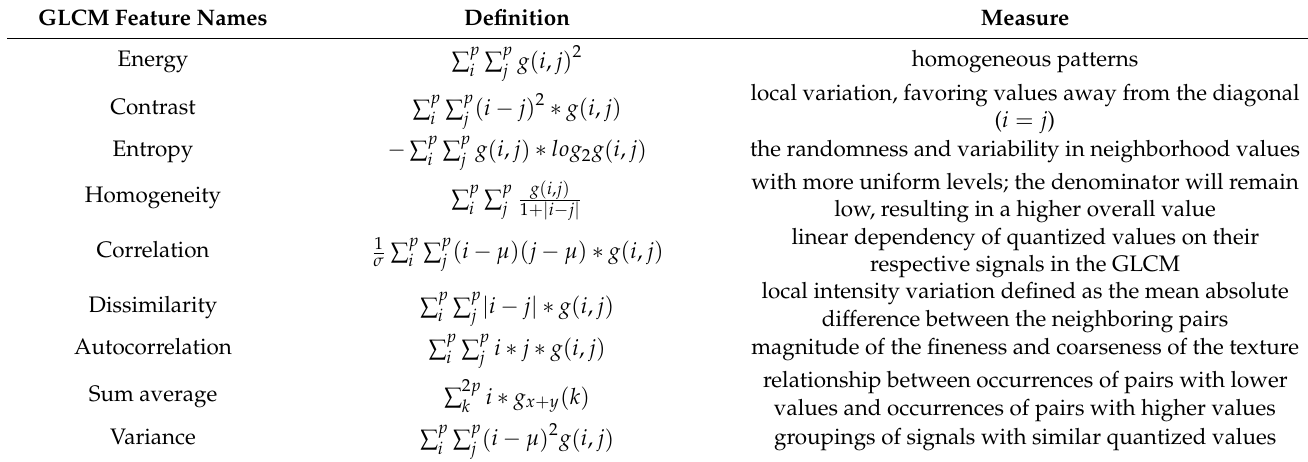
Table 2. GLCM features. g ( i , j ) is the normalized GLCM. µ and σ are the mean and standard deviation of g ( i , j ) , respectively. ∑ p g x + y ( k ) is obtained from ∑ p g ( i , j ) and k = i + j . i j